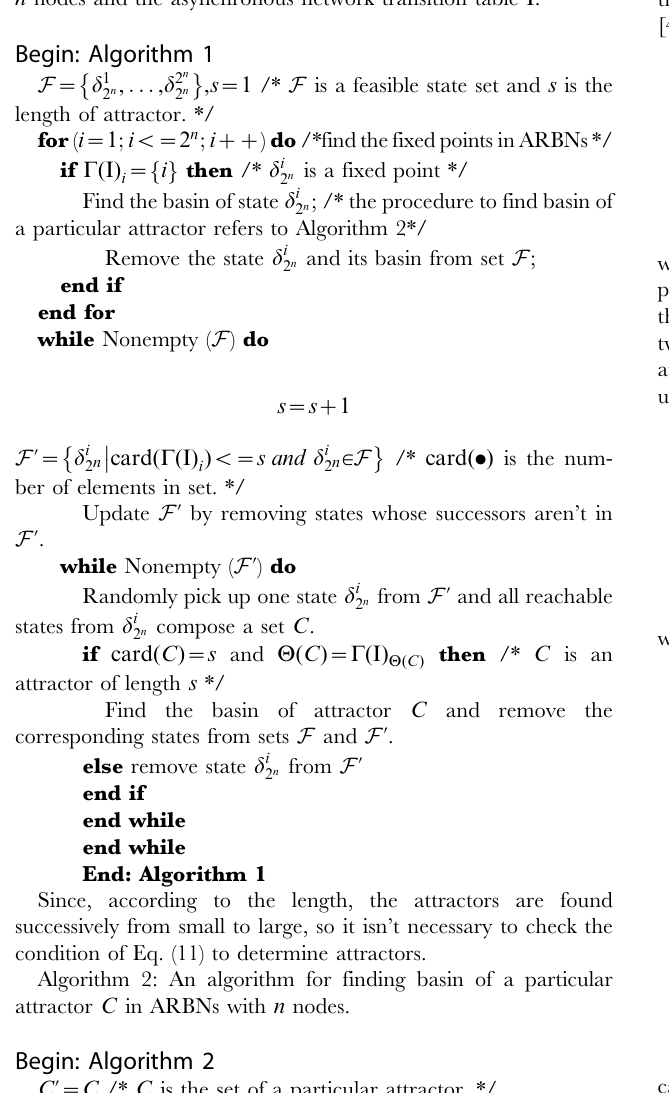
Algorithm 1: An algorithm for finding attractors in ARBNs with n nodes and the asynchronous network transition table I .